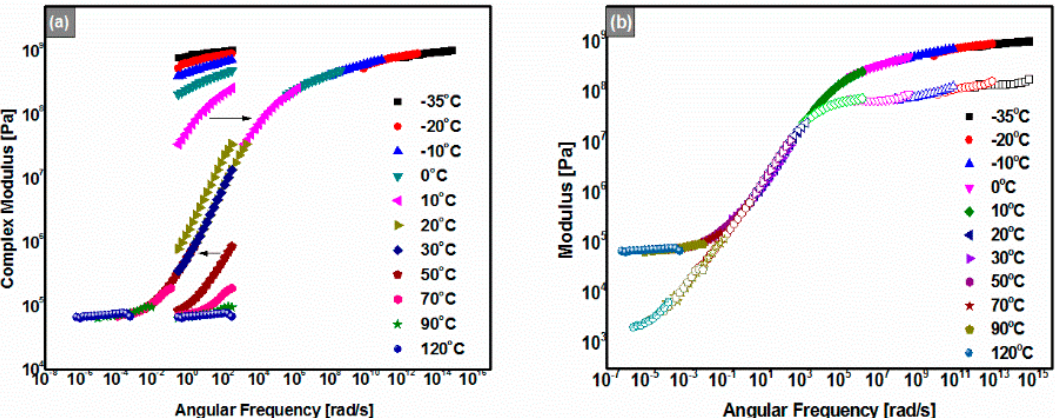
Figure 7. Master curves of the 180# ( T ref = 30 °C); ( a ) Complex modulus (| G *|) vs. frequency; ( b ) Storage modulus (| G ’|) (solid interior symbols) and loss modulus (| G ”|) (open interior symbols) vs. frequency.